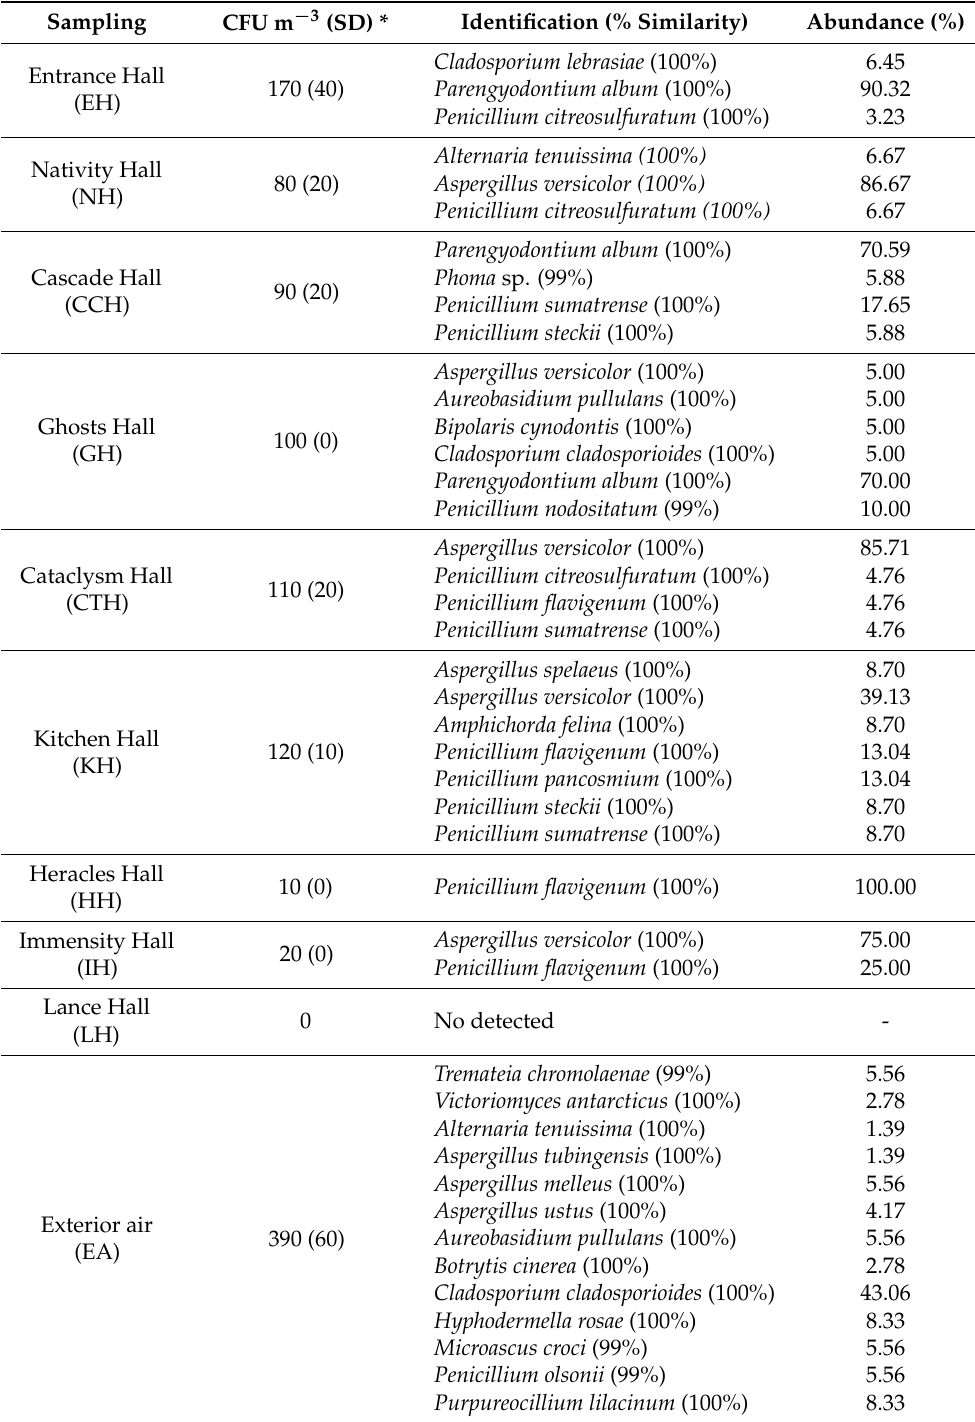
Table 2. Total counts, identifications, and abundance of fungi isolated from Nerja Cave in 2016 summer